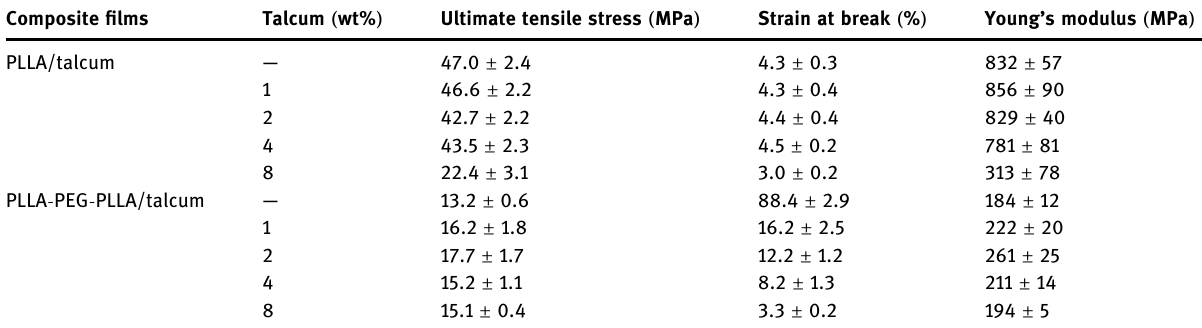
Table 4: Averaged tensile properties of PLLA/talcum and PLLA - PEG - PLLA/talcum fi lms Composite fi